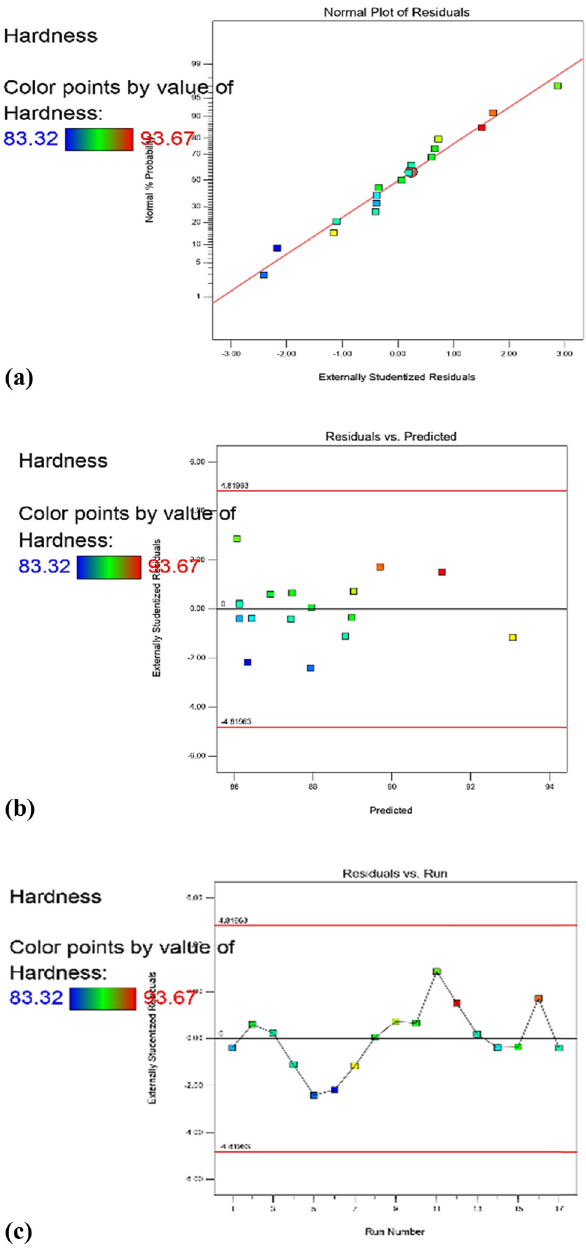
Figure 21: ( a ) Normal percent probability graph for hardness. ( b ) Residual vs predicted graph for hardness. ( c ) Residual vs run graph for